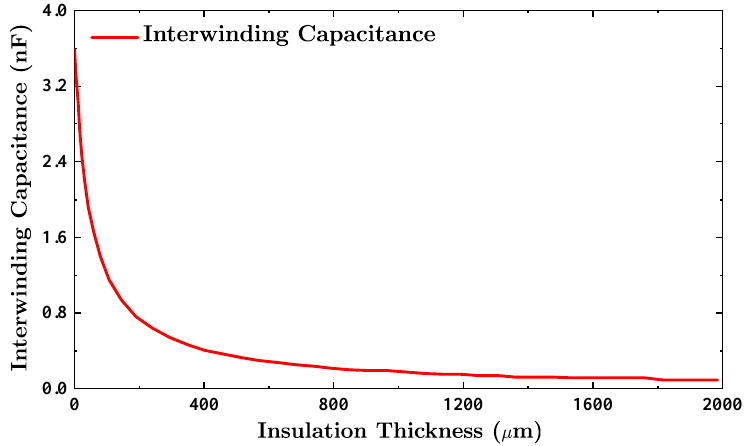
Figure 3. Hyperbolic change of Inter-winding Capacitance Based on the changes in the Insulation Thickness which proves the relation of the parasitic capacitances to the geometry of the magnetics. Reproduced with permission from [24], IEEE,